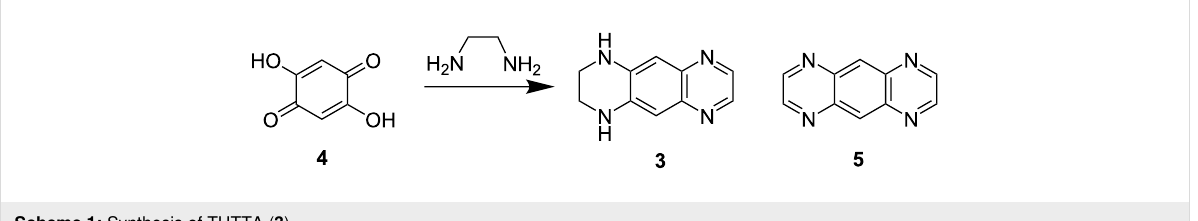
Scheme 1: Synthesis of THTTA ( 3 ).